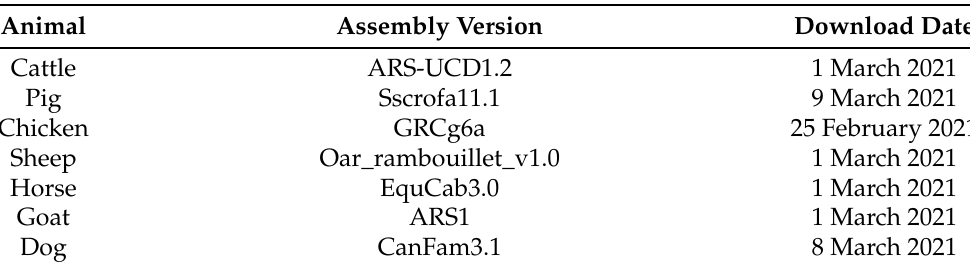
Table 2. Assembly versions of the input data, including the reference genome, SNP catalog, and gene annotations. All files were downloaded from Ensembl (release